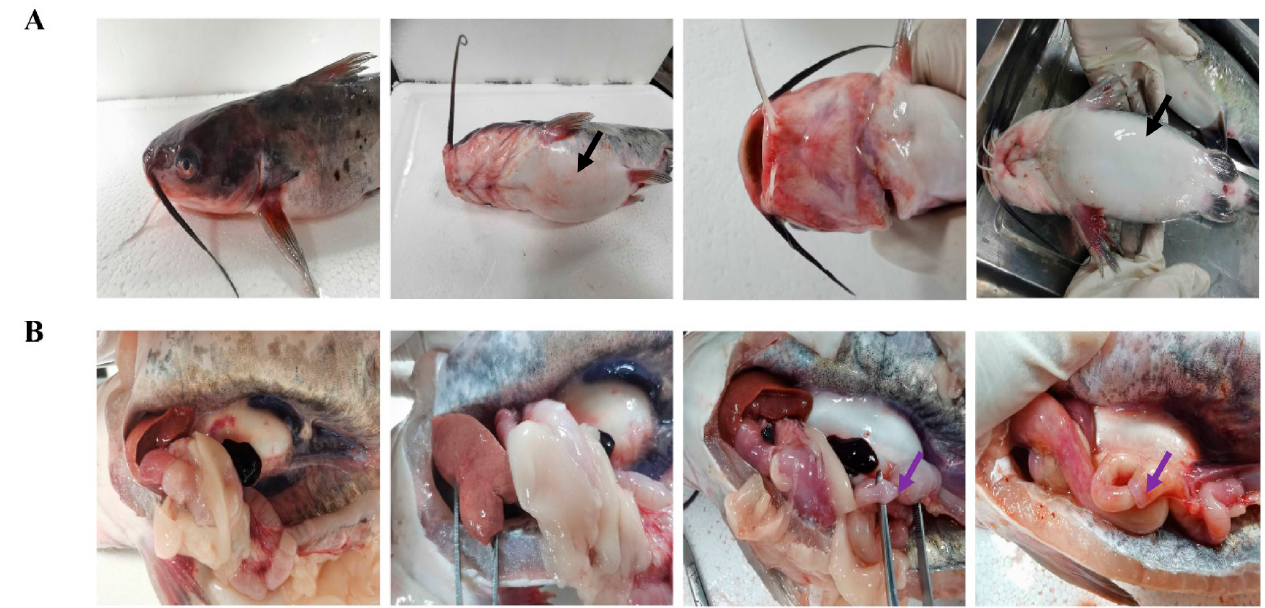
Figure 1. Natural features of A. veronii infection in channel catfish. The black arrow represents